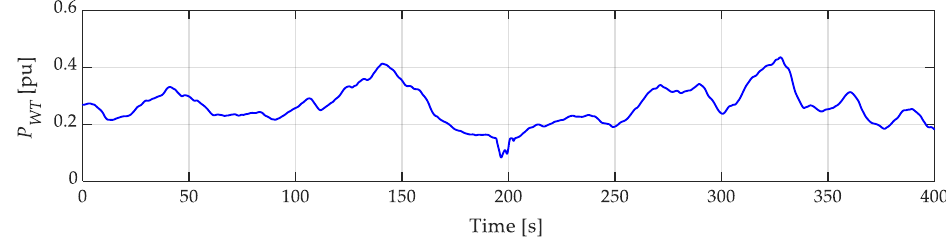
Figure 10. Wind power output from the VSWT model.